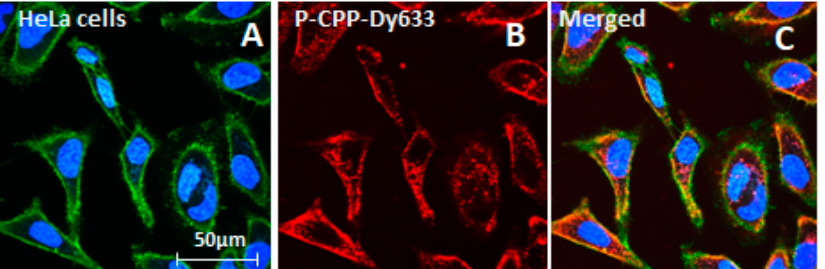
Figure 4. From left to right: ( A ) HeLa cells—nuclei are stained with Hoechst 33258 (colored blue) and cell membranes were stained with CellMask Green (colored green). ( B ) Fluorescently labeled polymer–peptide conjugate at 50 μ M concentration at 37 °C (specifically TAT12 ) after 2 h incubation. ( C ) Merge of cell staining with fluorescent contribution of labeled polymer conjugate.